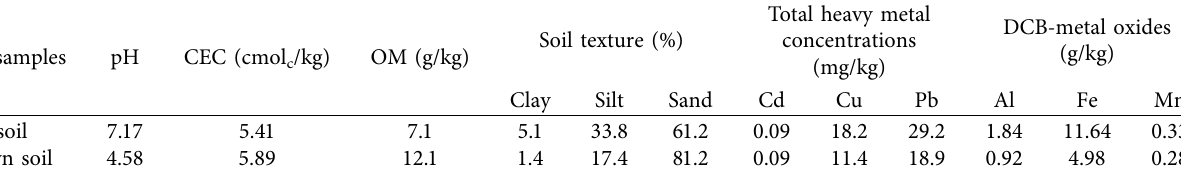
Table 1: Physicochemical properties of the soil samples.